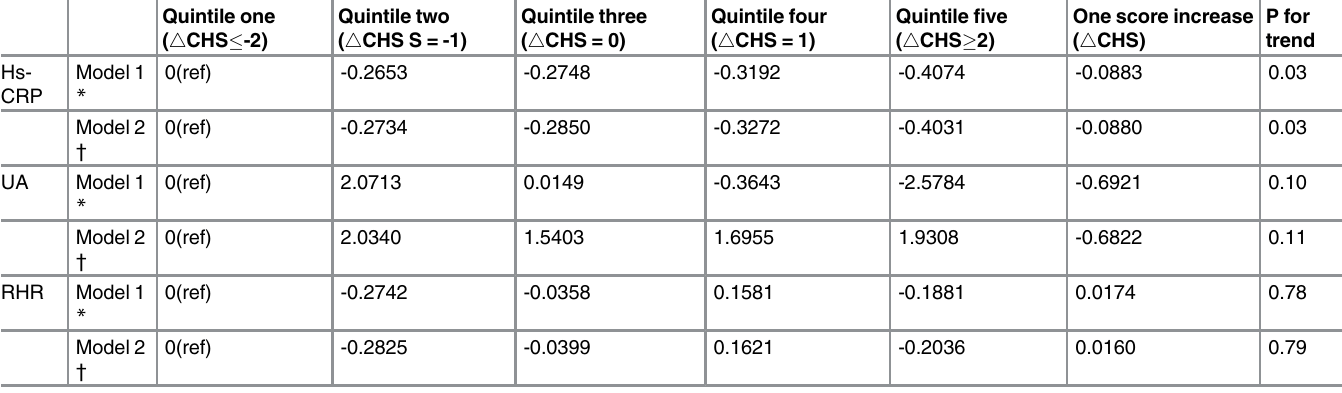
Table 6. Mean difference (95% confidence interval) in High sensitive C-reactive protein, UA, HR increase during 2008 – 2010, according to change of cardiovascular health score ( 4 CHS) from 2006 to 2008. Quintile one ( 4 CHS (cid:2)